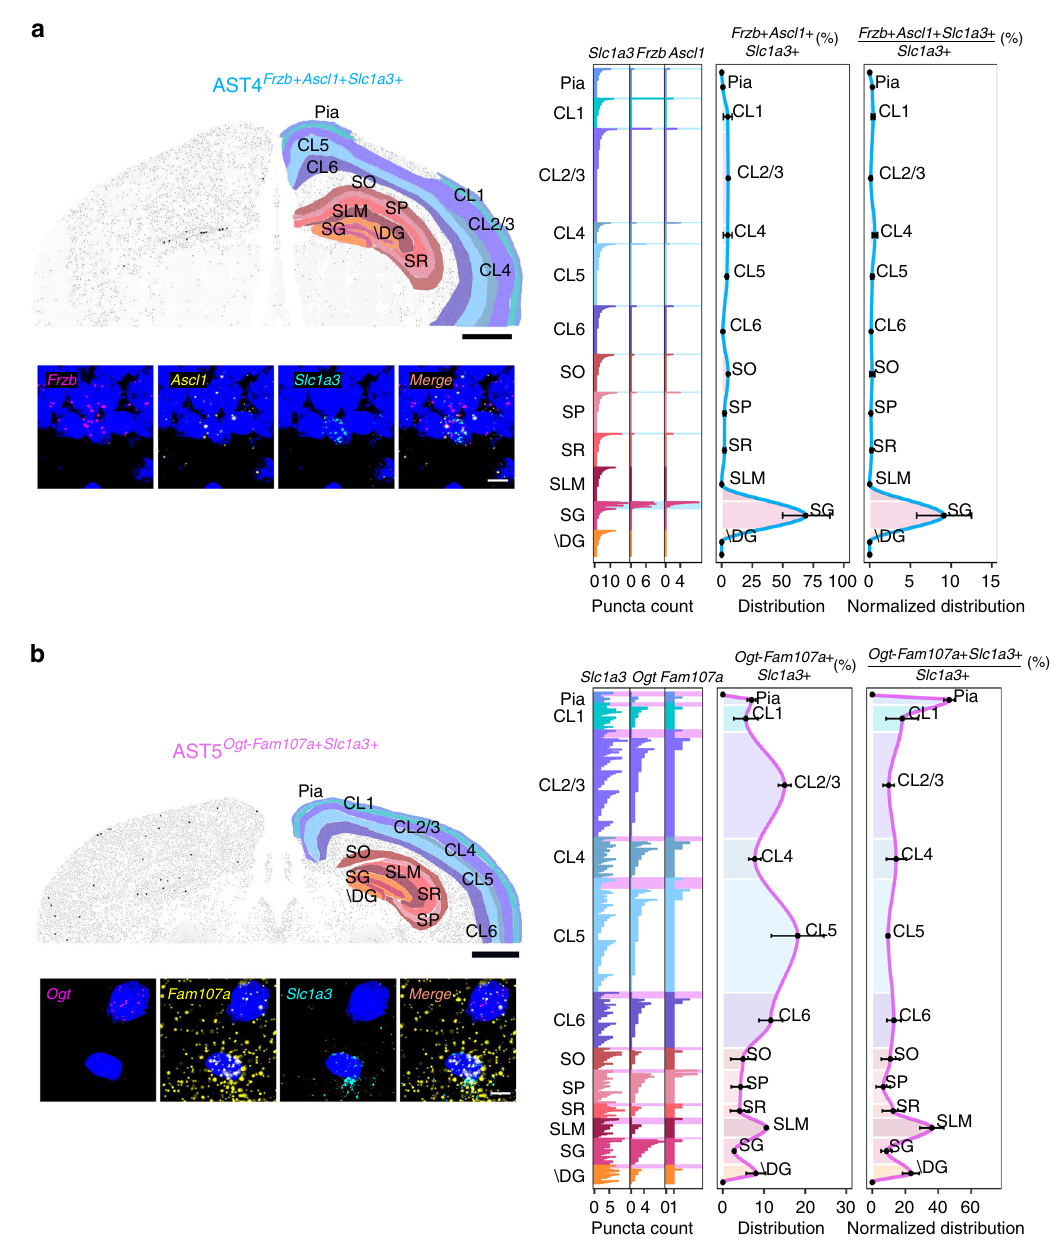
Fig. 4 Differential patterning of AST4 and AST5 in adult mouse brain. Multiplexed fl uorescence in situ hybridization was used to map locations of AST4 and AST5. a AST4 was identi fi ed by high expression levels of Frzb, Ascl1 , and Slc1a3 . b AST5 was identi fi ed by absence/low expression of Ogt and high expression of both Fam107a and Slc1a3 . Mapping was performed on three sections obtained from three independent animals aged between P56 – P60. Representative images are shown. Top left: low-magni fi cation image of a coronal section. Black dots show the distribution of the astrocyte subtype through one brain hemisphere. Brain regions are de fi ned manually based on de fi nitions from the Allen Brain Atlas. High-magni fi cation images (below) show the localization of markers to speci fi c cells de fi ned on the basis of nuclear (DAPI, blue) staining. Right: bar plots (showing from left to right) fl uorescence counts per RNA marker per cell (shown for all cells across all sections analyzed), the distribution of the subtype between brain regions and the distribution of the subtype normalized to the total number of astrocytes per brain region (all Slc1a3 + cells). Astrocytes belonging to the subtype of interest are highlighted by a shaded box (color-coded according to the scheme used in Fig. 2a). Astrocyte numbers across layers are given as average per section analyzed. Error bars are equivalent across the fi gure and represent SEM. Scale bars, low magni fi cation 1000 µ m; high magni fi cation, 10 µ m. “ + ” high gene expression, “ − ” low or absent gene expression. SO Stratum oriens, SP Stratum pyramidale, SR Stratum radiatum, SG Subgranular zone, \DG Dentate gyrus without SG, SLM Stratum (Supplementary Table 3), being enriched in genes involved in mitosis that AST5 represents an intermediate transition state between pro- and cell cycle control ( Sirt2 , Sept2 , Emp2 , etc). However, there were genitors and mature astrocytes. The distribution of AST5, based on also considerable differences, with AST5 being enriched for genes relatively high expression of Fam107a and low expression/absence involved in classical astrocyte functions, such as glucose metabolism of O gt (Fig. 4b and Supplementary Figs. 10 and 11), was dif fi cult and energy production (Supplementary Tables 6 and 8), suggesting to obtain accurately given the large variability between samples.